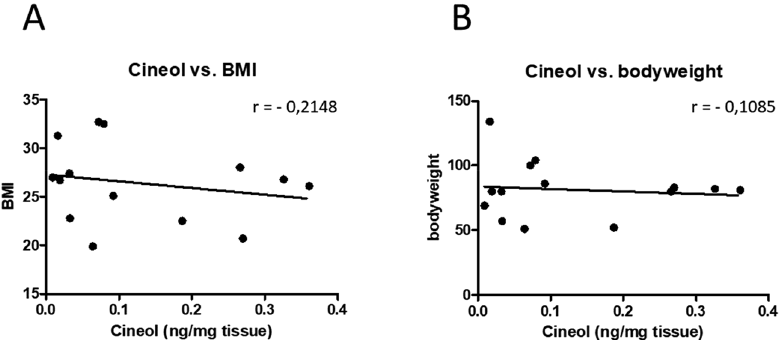
Figure 2. Correlation analysis between measured 1,8-Cineol concentrations (ng 1,8-Cineol /mg tissue) and patients ( A ) body mass index (BMI) and ( B ) bodyweight values. The Pearson correlation coefficient (r) is given.